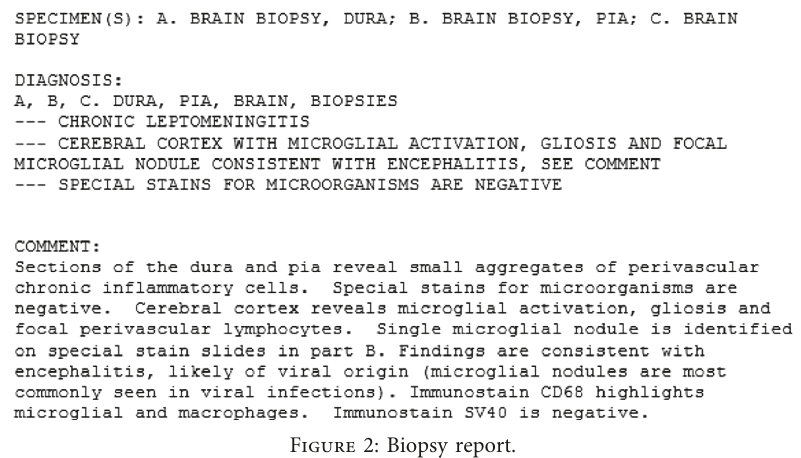
Figure 2: Biopsy report.